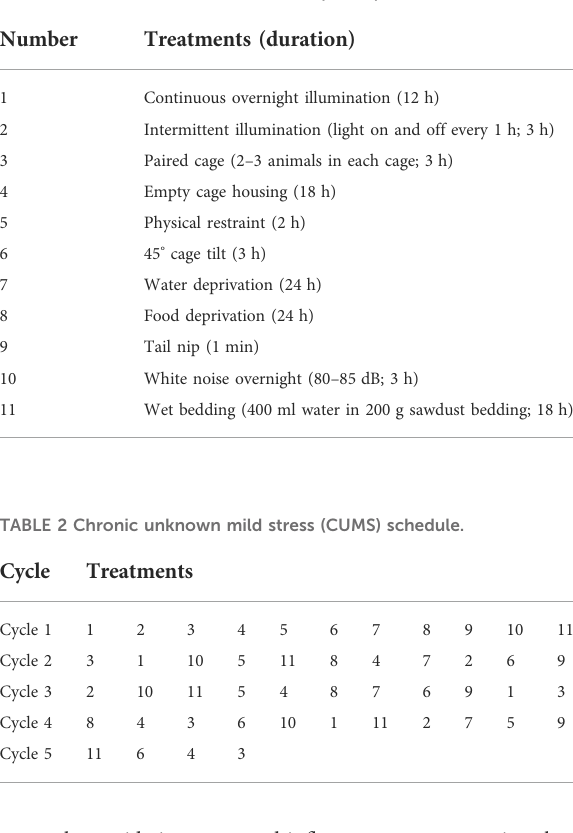
TABLE 1 Chronic unknown mild stress (CUMS).